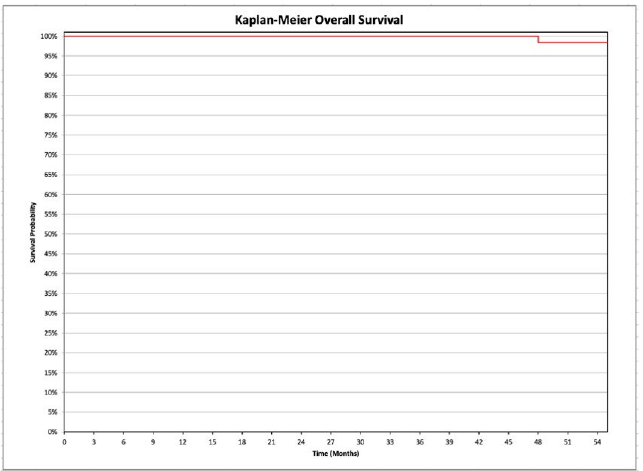
Figure 2. Kaplan-Meier analysis of the overall survival in the investigated population (women affected by in endometrioid ovarian cancers, and by synchronous endometrial-ovarian endometrioid cancers).